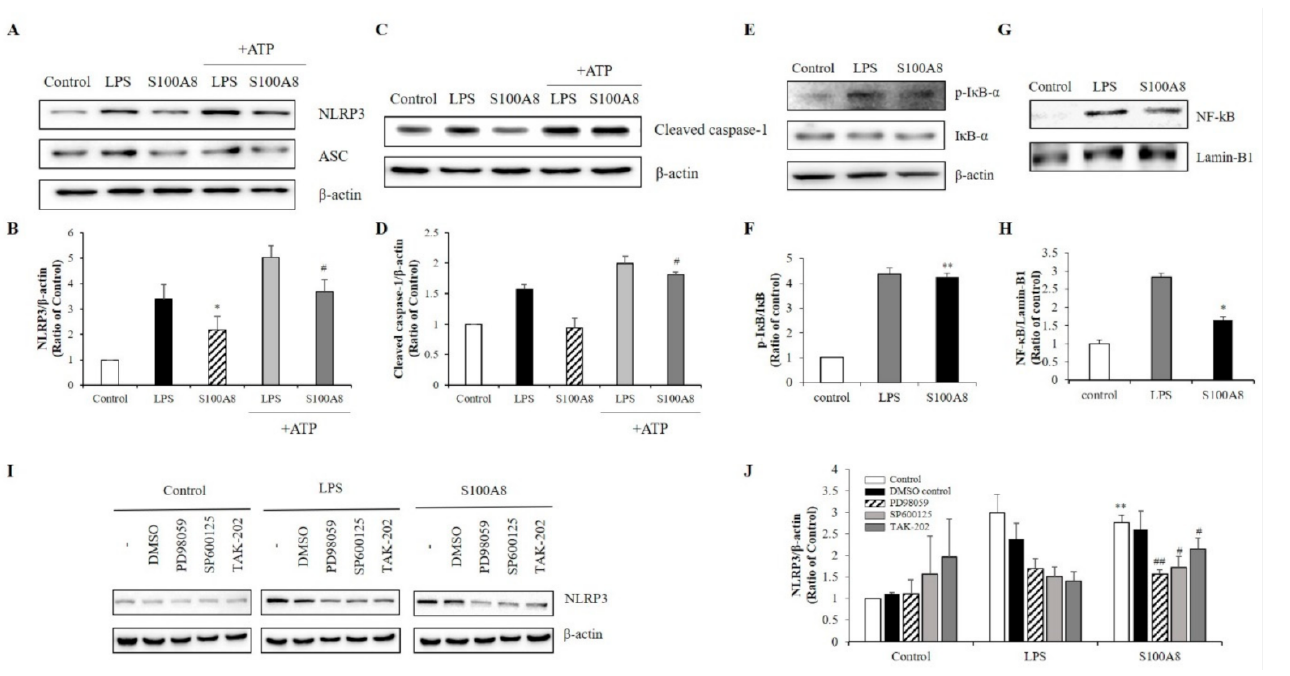
Figure 3. S100A8 induces inflammasome priming by toll-like receptor (TLR)-4 receptors associated with ERK and JNK pathway in BV-2 cells. BV-2 cells were incubated for 24 h with LPS (1 µ g/mL) or S100A8 (10 µ g/mL) followed by Adenosine 5 (cid:48) -triphosphate disodium salt hydrate (ATP) (1 mM) for 1 h. ( A , B ) The NLRP3, ASC, and ( C , D ) cleaved caspase-1 were detected by western blotting. β -actin was used as an internal control. ( E , F ) BV-2 cells were lysed to whole lysates and I κ B- α phosphorylation was analyzed by western blotting. ( G , H ) The translocation of nuclear factor- κ B (NF- κ B) was also detected by western blotting. BV-2 cells were lysed to cytosolic extracts and nucleic extracts. Lamin-B1 was used as internal controls. ( I , J ) BV-2 microglial cells were pre-treated with PD98059 (ERK inhibitor, 20 µ M), SP600125 (JNK inhibitor, 10 µ M), TAK-202 (TLR4 inhibitor, 10 µ g/mL) or an equivalent volume of DMSO and stimulated for 24 h with LPS or S100A8. Cells harvested and lysed in RIPA buffer for western blotting of NLRP3. Results are from one experiment that is representative of at least three others. Data from three independent experiments are presented as the means ± S.D. Values of * p < 0.05, ** p < 0.01 versus control; # p < 0.05, ## p < 0.01 versus S100A8-treated sample were considered as statistically